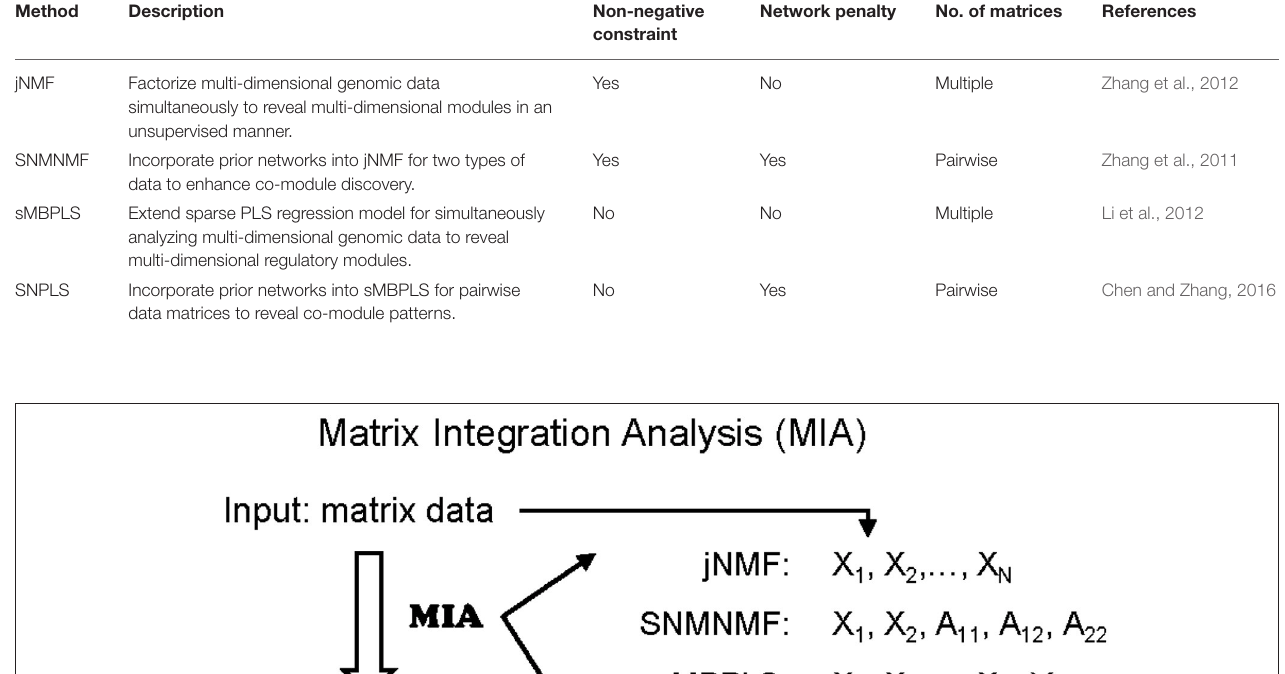
Frontiers in Genetics |